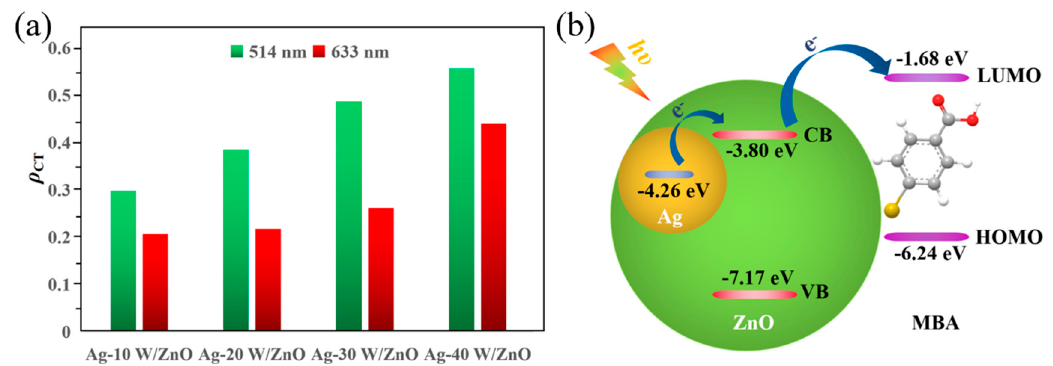
Figure 4. (a) Degree of charge transfer (CT; ρ CT ) in different Ag/ZnO/MBA systems under 514 and 633 nm laser excitations. (b) CT mechanism diagram of the Ag/ZnO/MBA system. The energy level schematic of the Ag/ZnO/MBA systems for the CT mechanism is shown in Figure 4b. The Fermi level of Ag was located at − 4.26 eV with reference to the vacuum level [29]. The highest occupied molecular orbital (HOMO) and the lowest unoccupied molecular orbital (LUMO) levels of MBA were situated at − 6.24 and − 1.68 eV, respectively [30]. The conduction band (CB) and valence band (VB) of ZnO were situated at − 3.80 and − 7.17 eV, respectively. [29] The energy barrier from the Fermi level of Ag to the LUMO of MBA was 2.58 eV, which was higher than the incident photon energy (514 nm, 2.41 eV, and 633 nm, 1.96 eV). Thus, the incident photons did not have